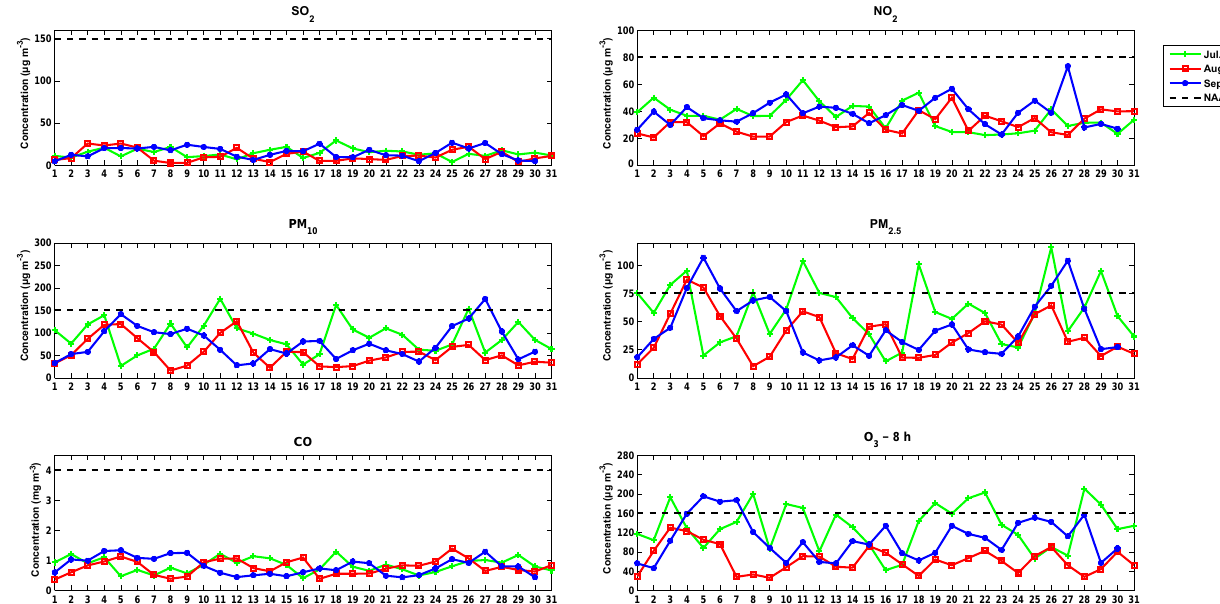
Figure 6. Day-to-day variations in SO 2 , NO 2 , PM 10 , PM 2 . 5 , CO and O 3 -8h at XL station in July, August and September 2014 (CST). Observed data for July, August and September 2014 are indicated in green, red and blue respectively. NAAQS are indicated with a black dotted